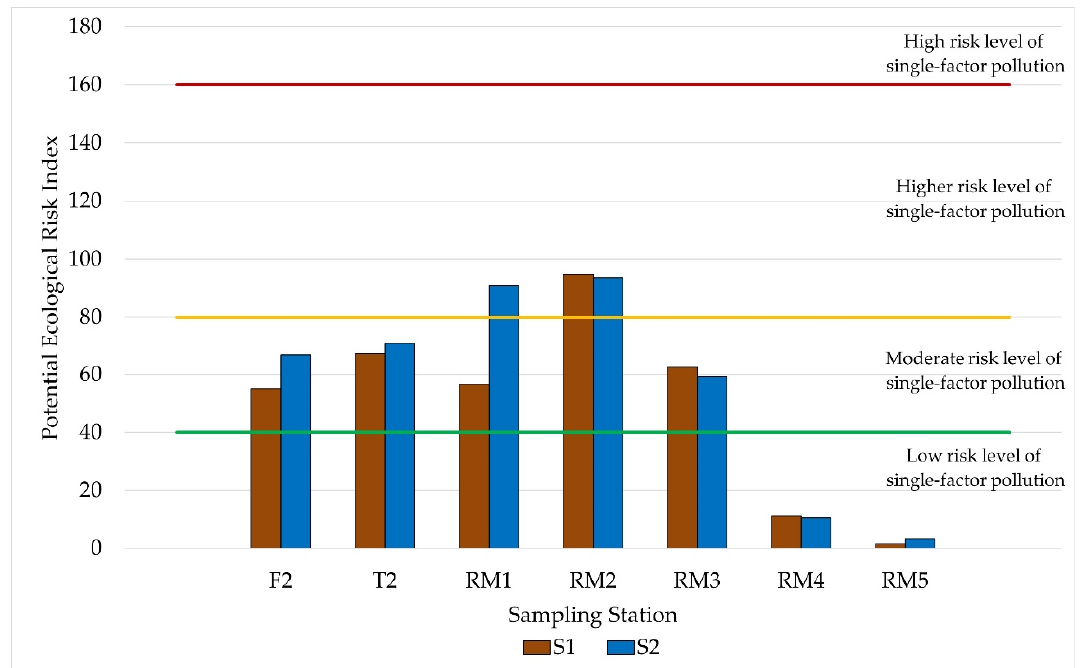
Figure 6. Values of the ecological risk potential index (E F ) in the sediment samples collected in the Reis Magos River Hydrographic Basin.